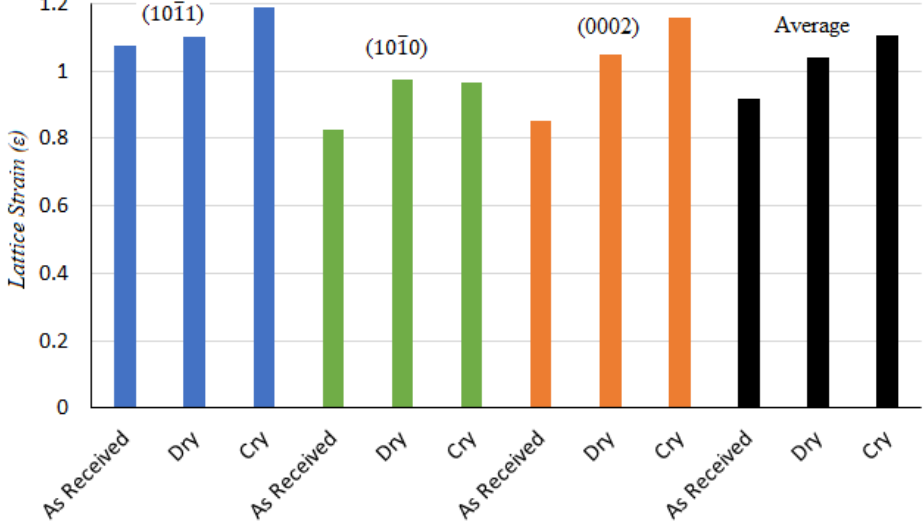
Figure 10. Lattice strain for each peak and the average crystallite size for the as-received sample, after dry turning and after cryogenic turning.